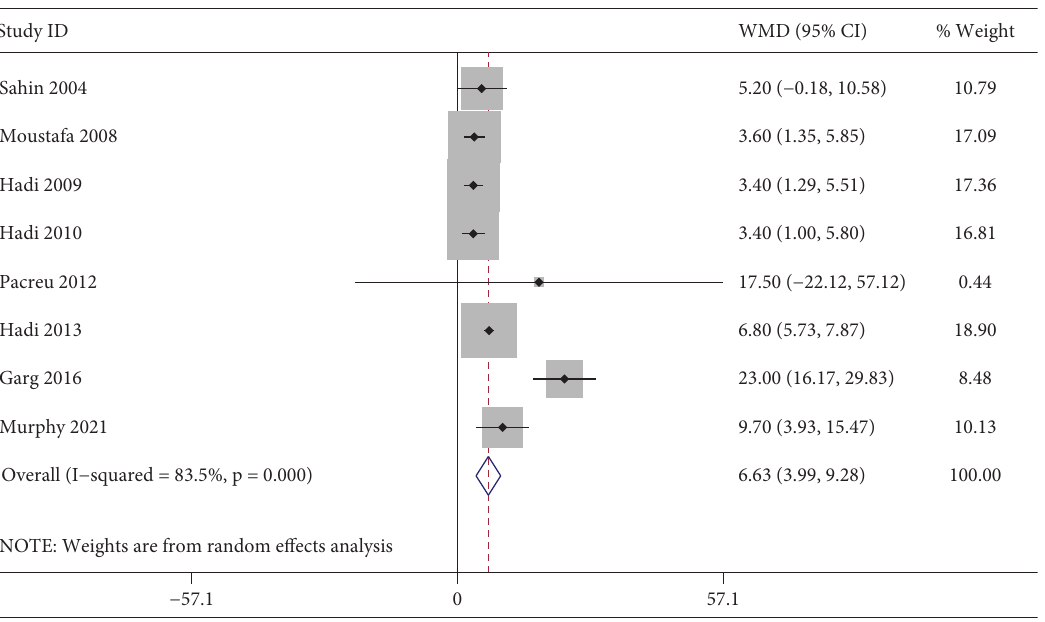
Figure 6: Forest plot of the time to first request for analgesic after surgery for the ketamine group and control